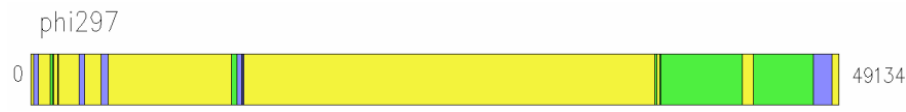
Figure 7. Genome of phage phi297 has homology regions of different sizes and locations with D3 and F116 genomes (yellow: phi297 own genes; green: fragments of homology with D3 DNA; blue: fragments of homology with F116